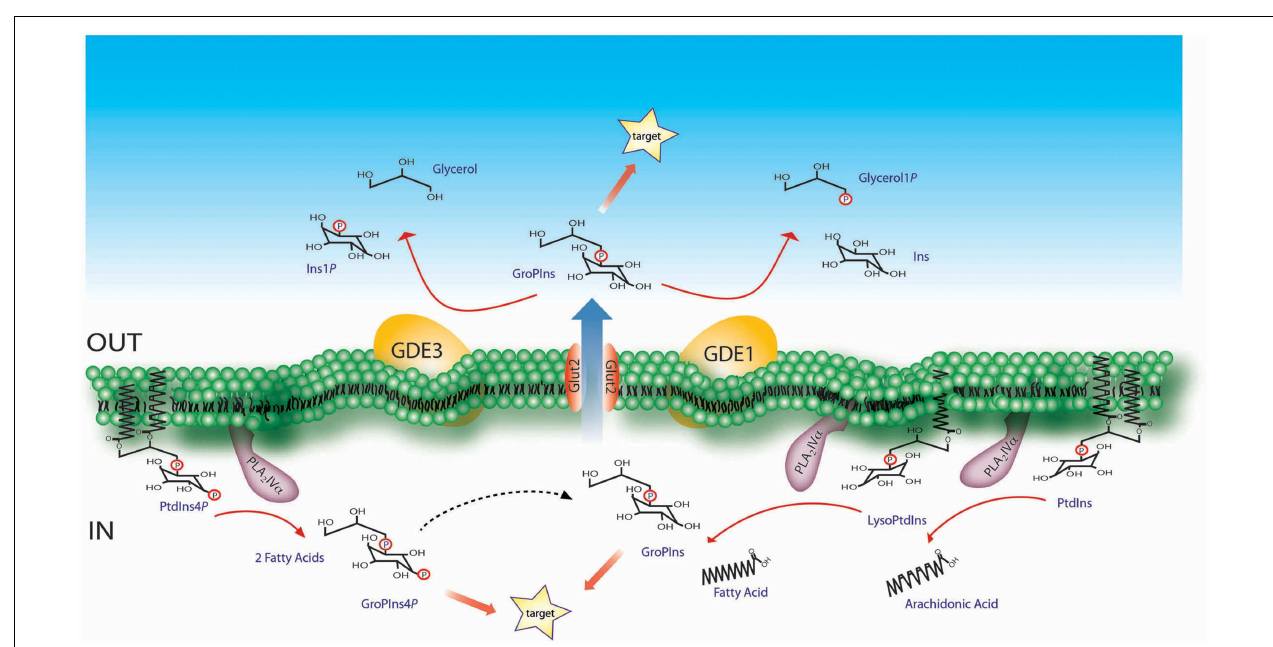
substrates together with the recombinant enzyme (4). Once produced in the cytoplasm, GroPIns can be active on intracellular targets or can be released through the Glut2 transporter into the extracellular space, where it can act as a paracrine factor on nearby target cells.The subsequent catabolism of GroPIns is instead located on the extracellular side of the plasma-membrane and is mediated by the GDEs. GroPIns4 P formation, also schematized, occurs starting from membrane phosphatidylinositol 4-phosphate which is hydrolyzed, as for GroPIns, by PLA 2 IV α (unpublished observations, see main text for